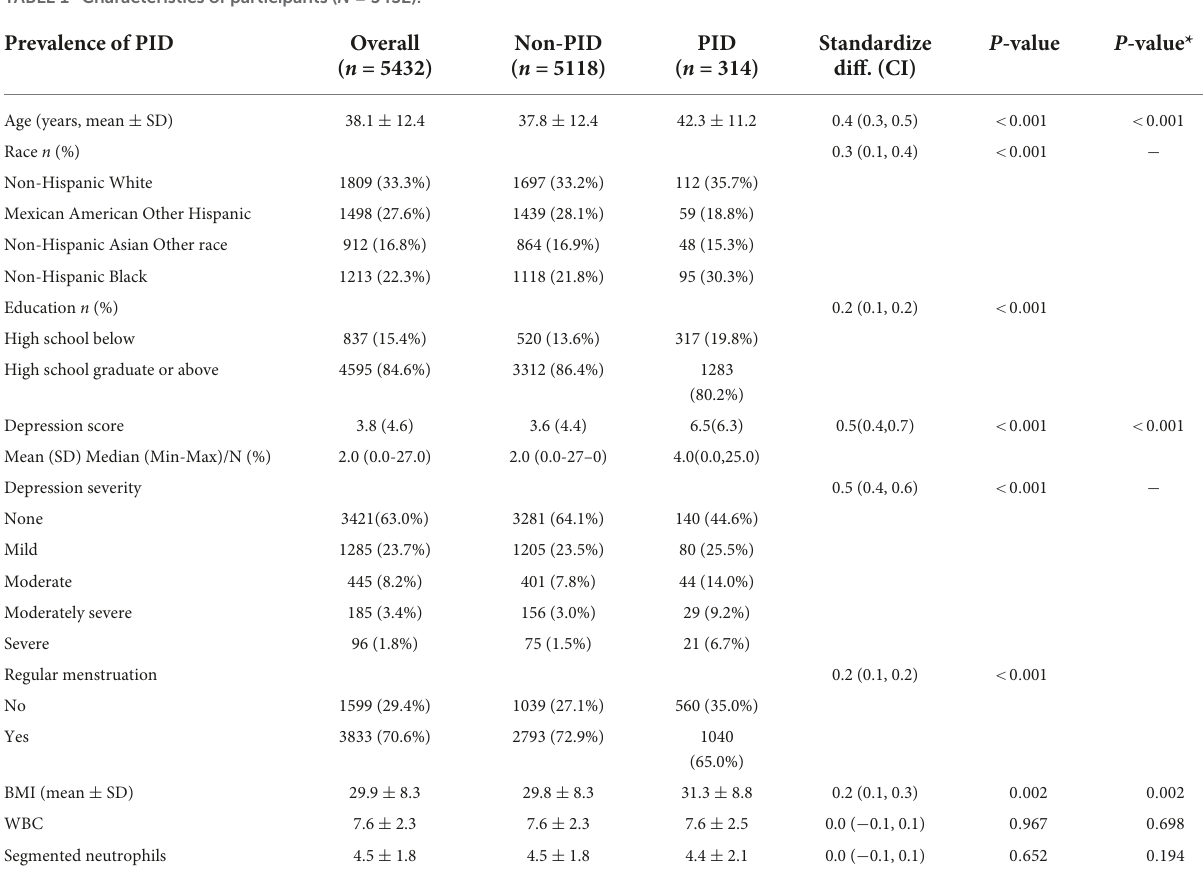
TABLE 1 Characteristics of participants ( N =